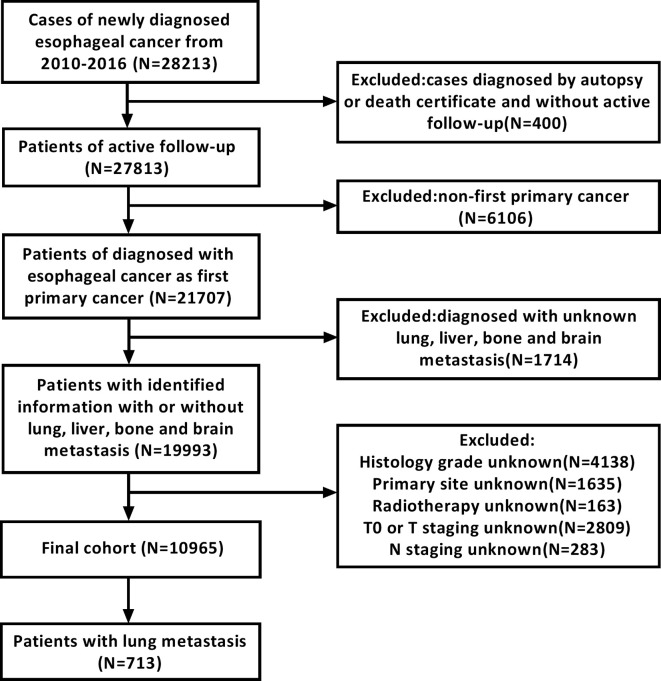
Flowchart of the esophageal cancer patients selection from SEER database.